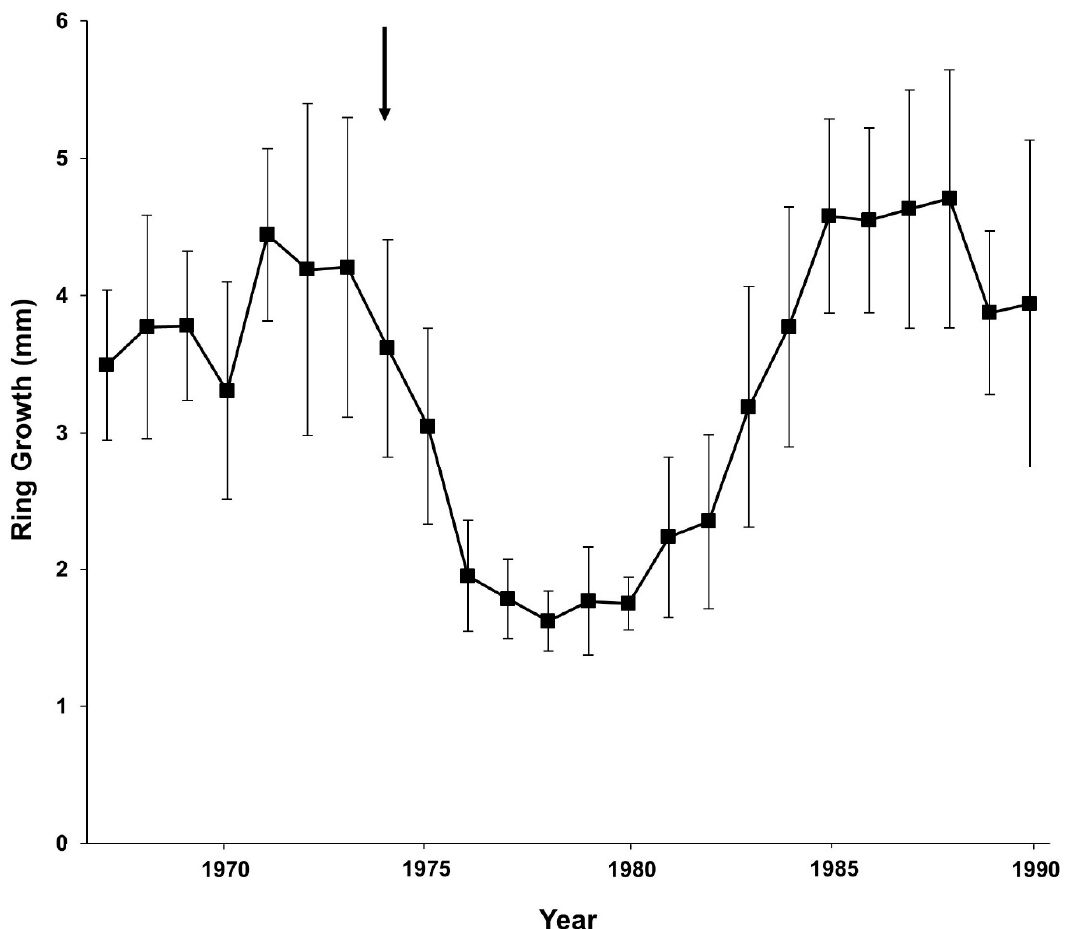
Figure 5. Yearly changes in radial growth of P. densiflora sampled around the Yeocheon industrial complex. The arrow indicates when the industrial facility began to operate in this area.